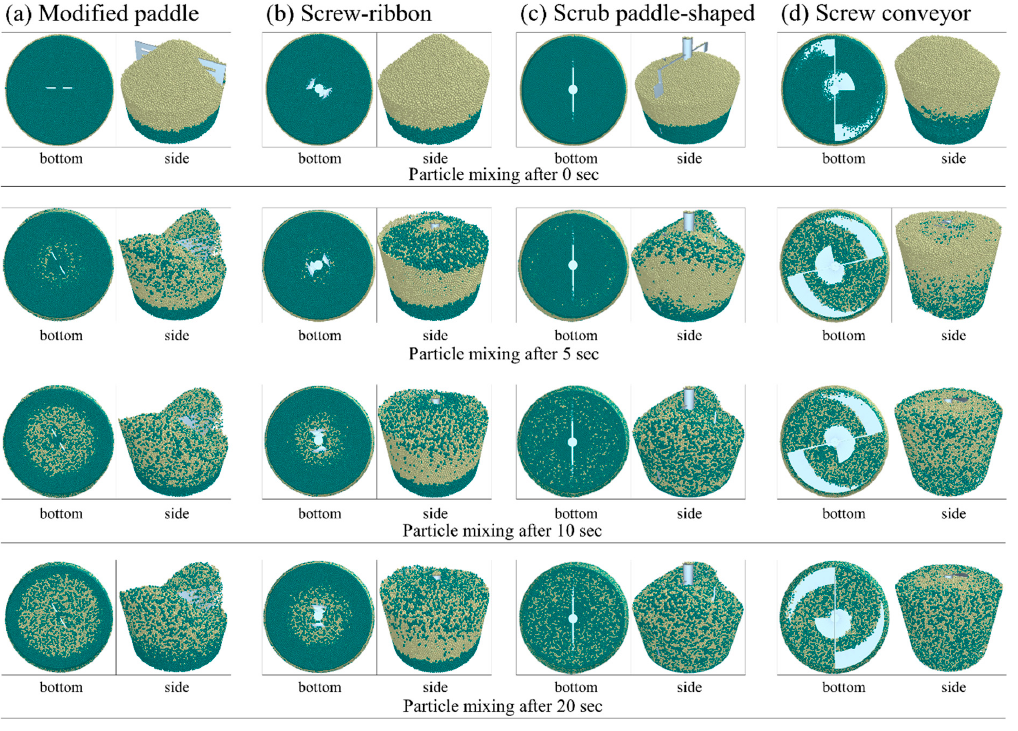
Figure 12. Simulated mixing patterns of powder particles at 0, 5, 10, and 20 sec: ( a ) modified pad- dle, ( b ) screw-ribbon, ( c ) scrub paddle-shaped, and ( d ) screw conveyor. ( b ) screw-ribbon, ( c ) scrub paddle-shaped, and ( d ) screw conveyor.